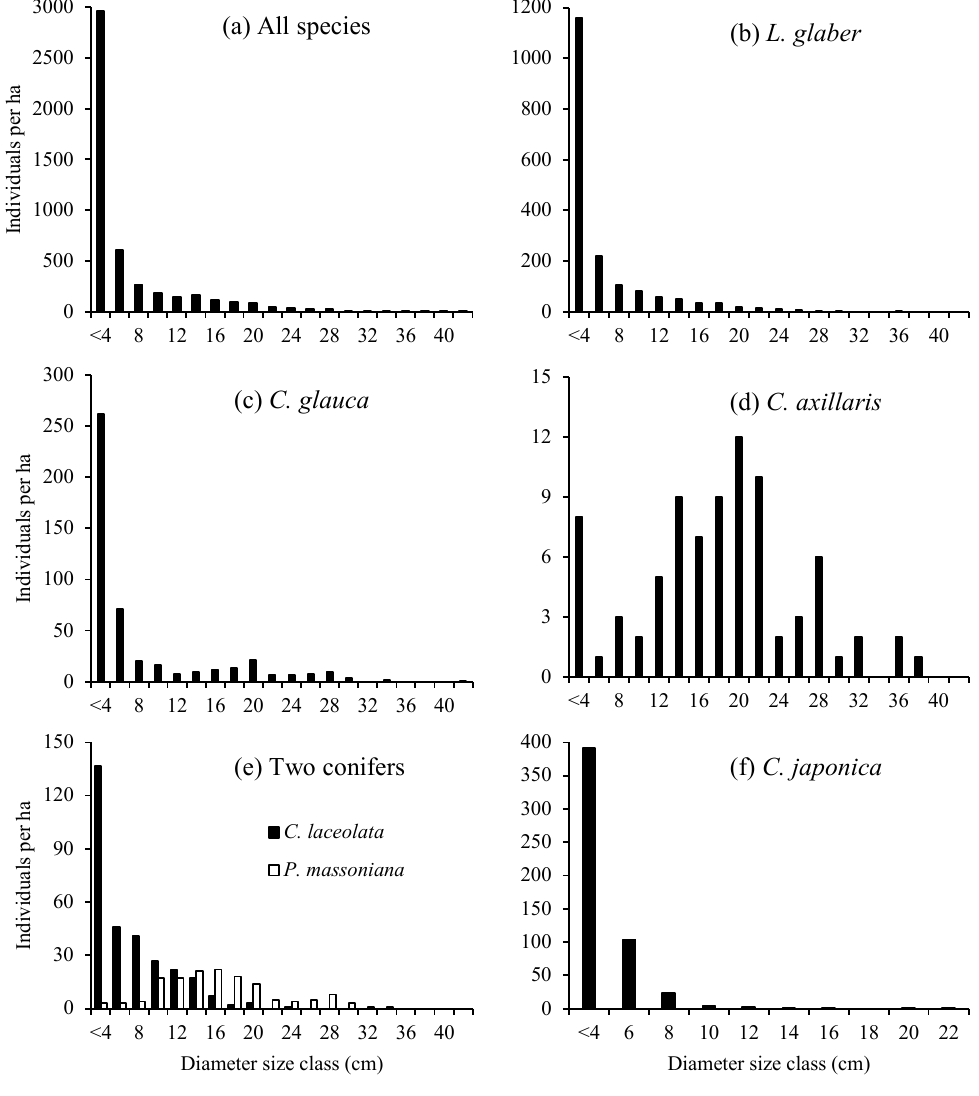
Figure 2. Distribution of diameter at breast height ( dbh ) size classes (at 2 cm intervals) for all woody species ( a ); two broadleaved evergreen tree species ( L. glaber ( b ) and C. glauca ( c )); a deciduous tree species ( d ); two coniferous tree species ( e ) and an evergreen shrub species ( f